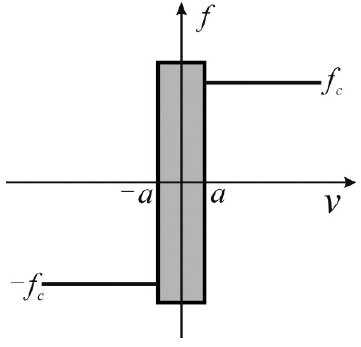
Figure 3. Karnopp friction model.